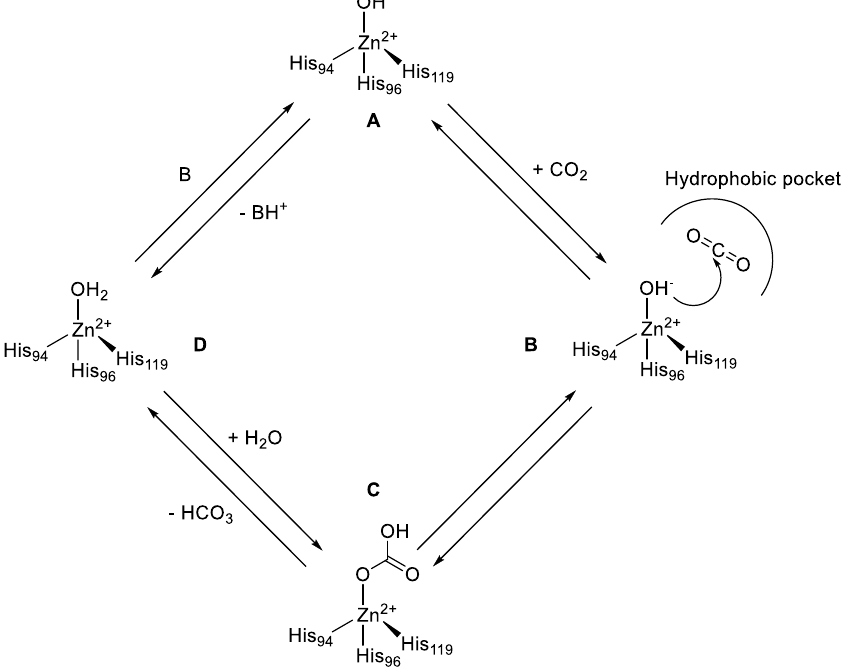
Figure 1. Catalytic mechanism of reversible hydration of CO 2 to HCO 3 − and a proton in the presence of α -CAs.